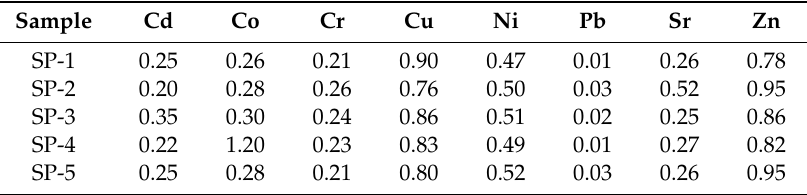
Table 1. Ratio of the measured metal concentrations in the saponite pulp samples (SP) to the maximum permissible concentrations in